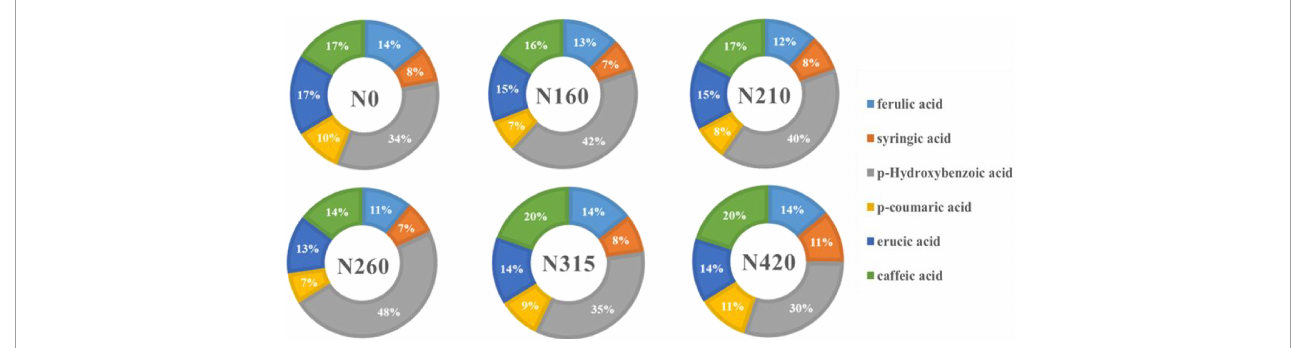
FIGURE2 Effect of different amounts of nitrogen fertilization on phenolic composition of brown rice.